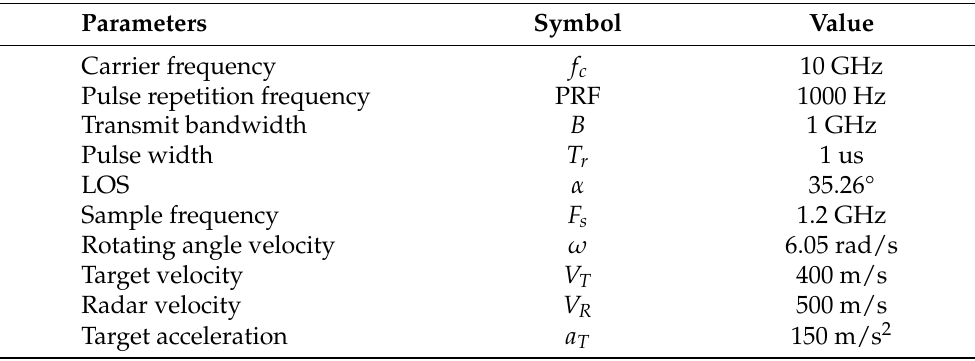
Table 1. Simulation parameters of ISAR